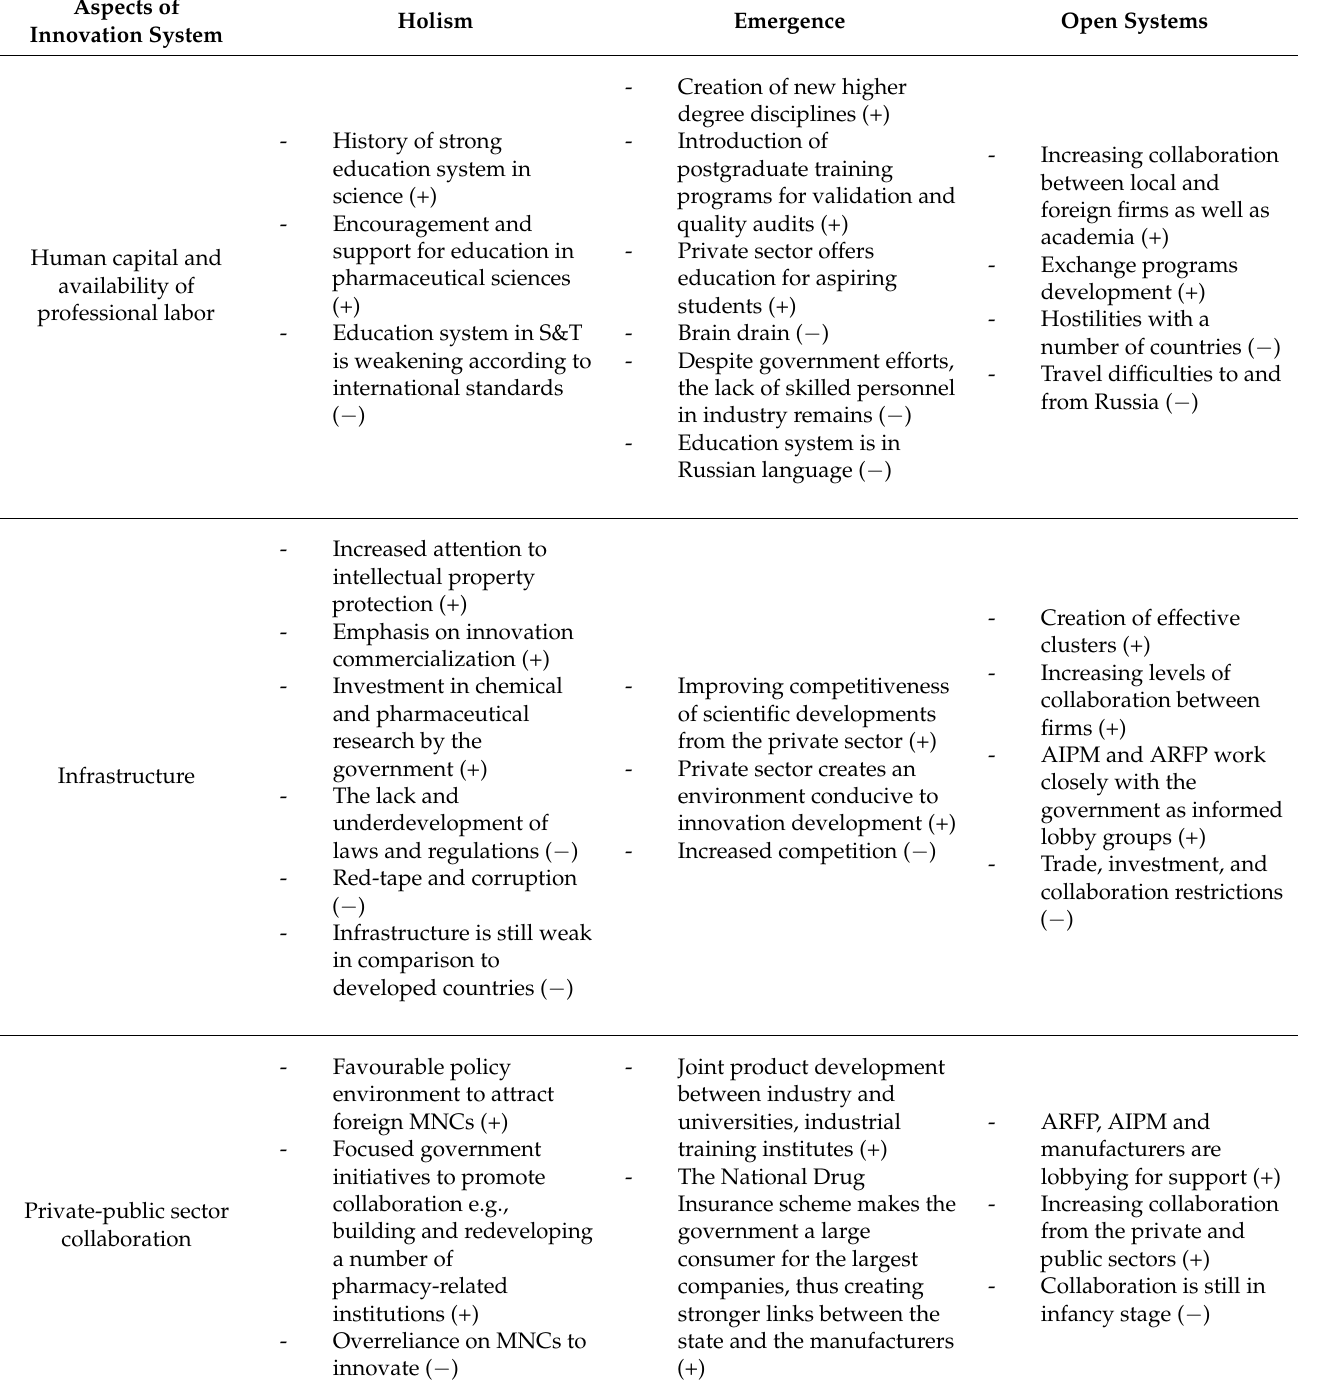
Table 4. The systems perspective of Russia’s pharmaceutical